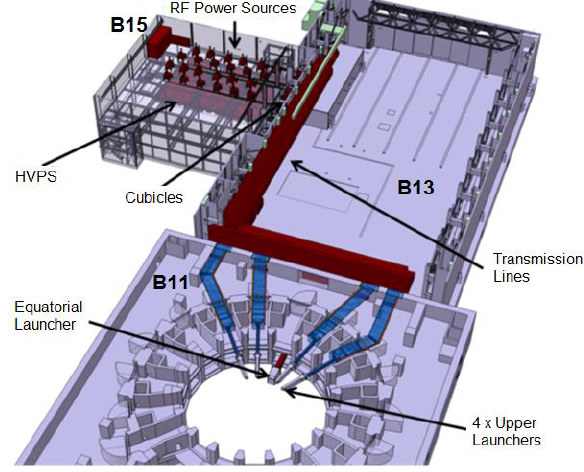
Fig. 1. ITER ECH&CD plant